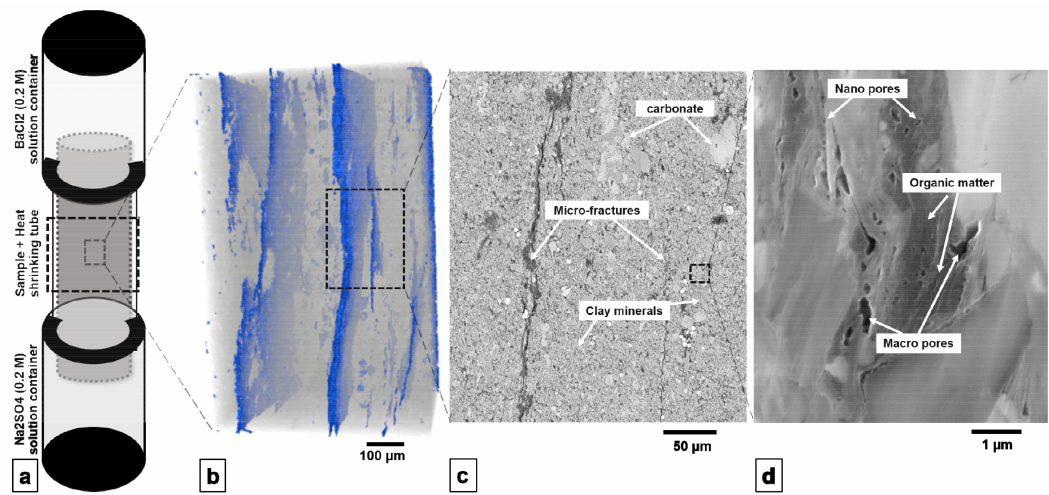
Figure 1. ( a ) Schematic representation of the experimental setup. ( b ) 3D view of the microfractures in the sample before wetting. ( c ) Electron Backscattering image of a cross-section of a representative microstructure of shale similar to our sample, showing microfractures and the nanoporous matrix. ( d ) higher-resolution Secondary electron image of the nanoporous matrix. In (a) the thick dash box corresponds to the imaged field of view at the central zone of the sample (3.5 mm width × 3 mm height) and in (b–d) dash boxes are showing the scale, not the exact areas of the